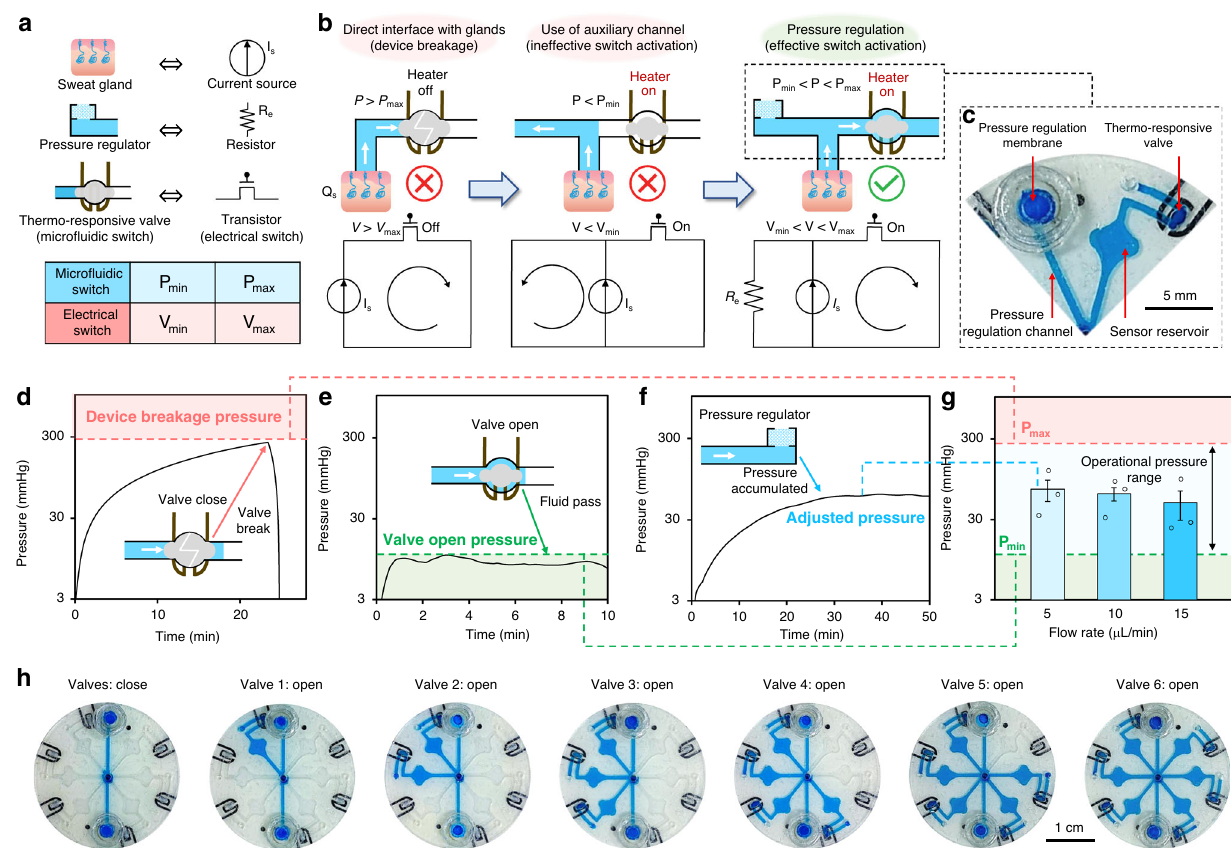
Fig. 3 Elaboration, characterization, and demonstration of pressure-regulated valving. a An electric-hydraulic analogy. ( V min : minimum turn-on voltage of the transistor switch; V max : maximum tolerable voltage of the transistor switch; P min : minimum required pressure to open the valve; P max : maximum tolerable pressure of the hydraulic valve). b Design rationale of the pressure regulation mechanism (assisted by the electrical circuit analogy). c Optical image of the implemented pressure-regulated valve. Real-time pressure recording for the characterization of the d maximum tolerable pressure, e minimum required pressure, and f regulated pressure. Input fl ow rate was set to 5 μ L min − 1 . g Characterized accumulated pressure across pressure- regulated micro fl uidic channels at different fl ow rates. Error bars, mean ± s.e ( n = 3 measurements from different devices). h Sequential optical images